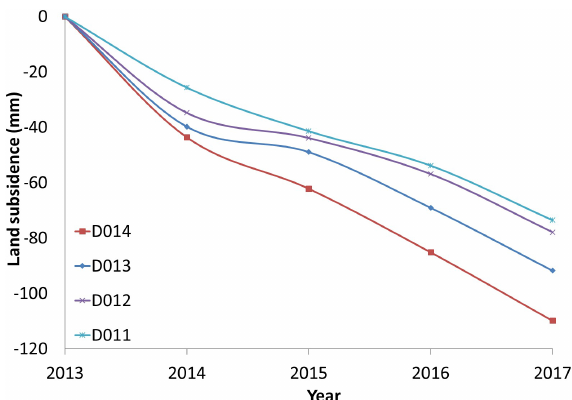
Figure 5. Land subsidence curves (the thickness of the lower soft soil layer (3) + (4) at D008 is about 7m, the thickness of layer (3) + (4) at D007 and D006 is about 5m, and the thickness of layer (3) + (4) at D003 is about